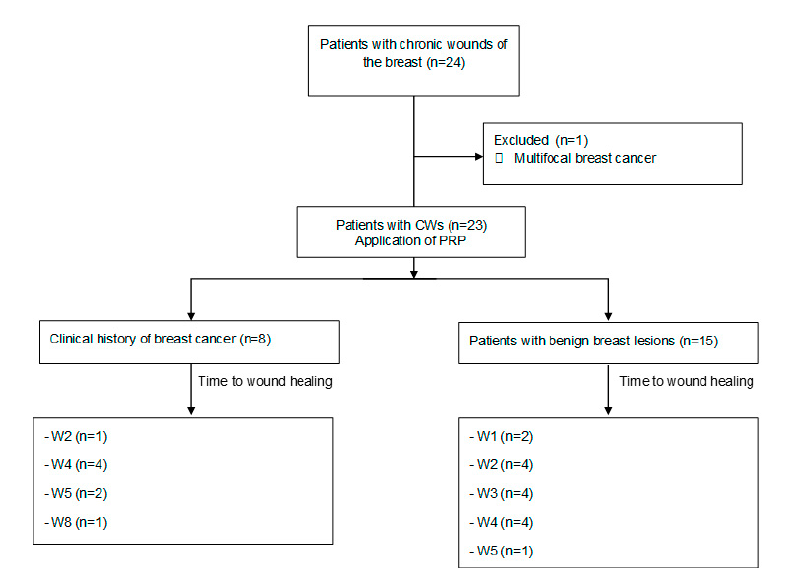
Figure 2. Flow diagram of the patients in this study. CWs: chronic wounds; PRP: platelet-rich plasma; W: week.